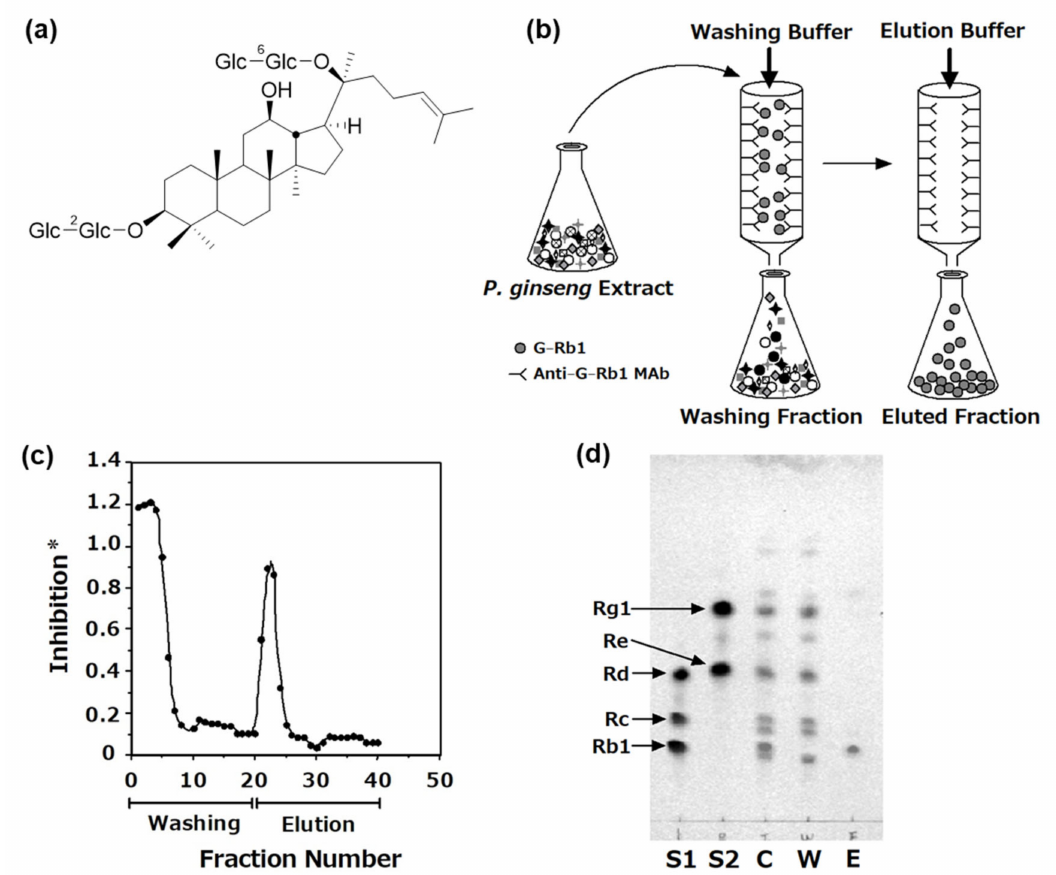
Figure 2. ( a ) Chemical structure of G-Rb1. ( b ) Scheme showing the fractionation using the anti-G-Rb1 MAb-coupled immunoaffinity column. ( c ) Elution profile of the P. ginseng crude extract separated using the immunoaffinity column. ELISA using anti-G-Rb1 MAb determined the concentrations of G-Rb1 in each fraction (1–40). * Inhibition = (A0 − A)/A0, where A0 is the absorbance in the absence of the test compounds and A is the absorbance in the presence of the test compounds. ( d ) TLC profile of the fractions obtained from the immunoaffinity column. S1: G-Rd, G-Rc, and G-Rb1, S2: G-Rg1 and G-Re, C: P. ginseng crude extract, W: washing fraction, E: eluted